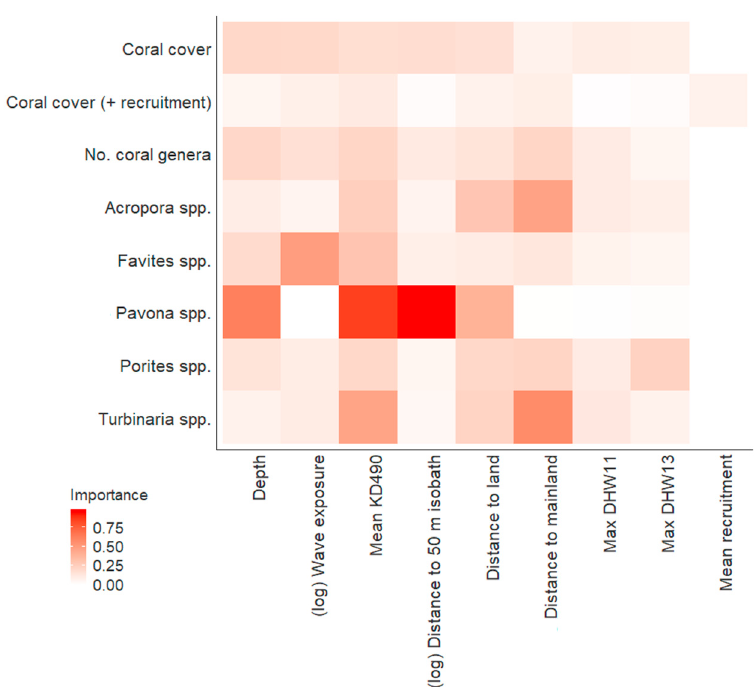
Figure 5. Variable importance plot for generalised additive mixed models for coral cover, diversity, and the cover of Acropora, Favites, Pavona, Porites and Turbinaria spp. corals in the Dampier Archipelago, Western Australia (Table 3).